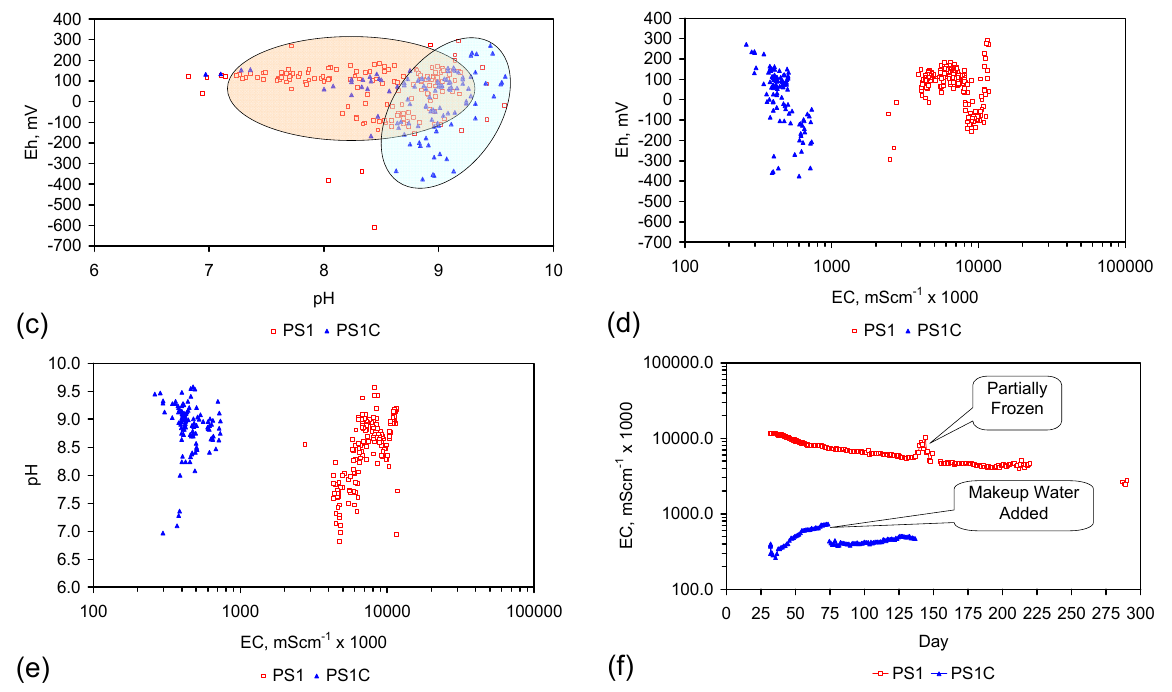
Figure D1. ( a ) Eh vs. day; ( b ) pH vs. day; ( c ) pH vs. EC; ( d ) Eh vs. EC; ( e ) pH vs. EC; ( f ) EC vs. day. ZVM TP = particulate material placed in water at a concentration of